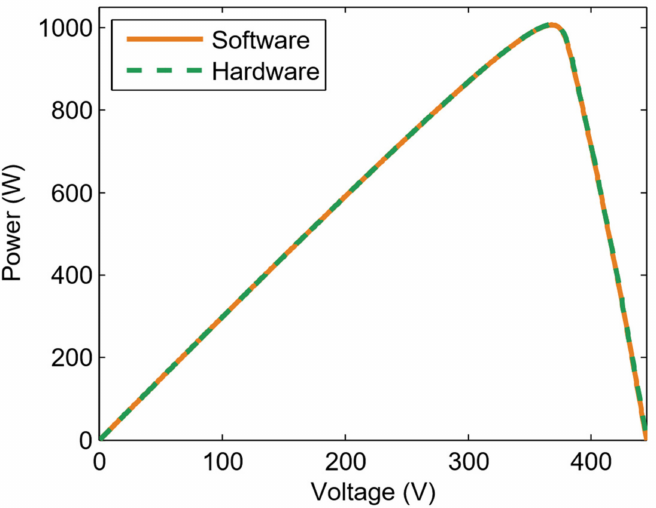
Figure 18. V–I characteristic curves of the direct model and the photovoltaic array